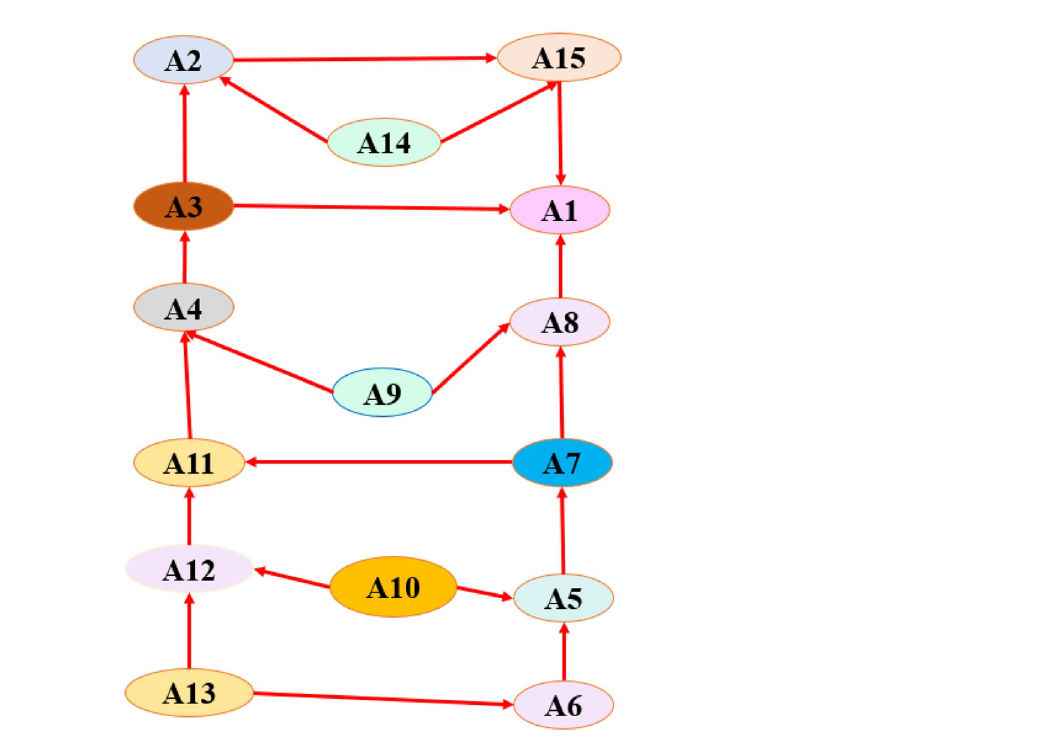
Figure 3. Interrelationship between the fifteen